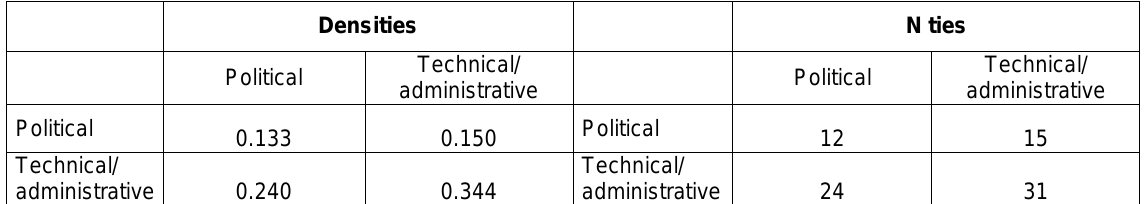
Table 3: Intensity of information exchange between political duty bearers & technical/administrative staff Densities N